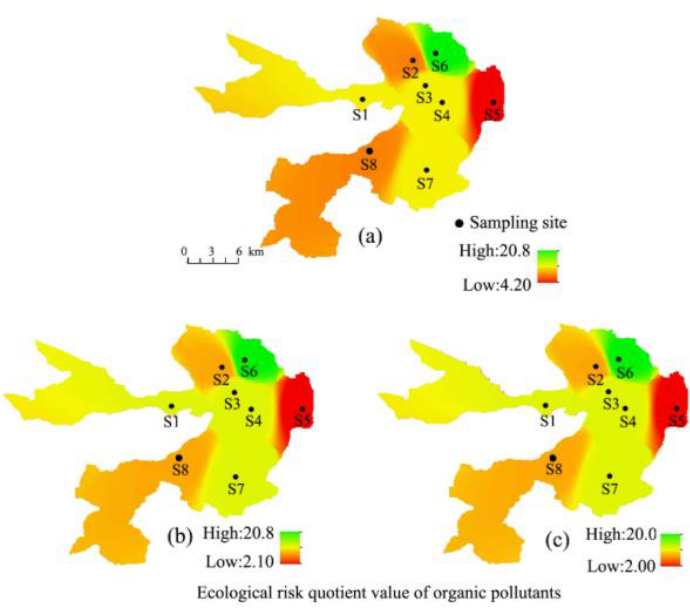
Figure 5. Risk quotient in the spring, summer, and autumn. Figure 3. Eutrophication index in the spring ( a ), summer ( b ), and autumn ( c